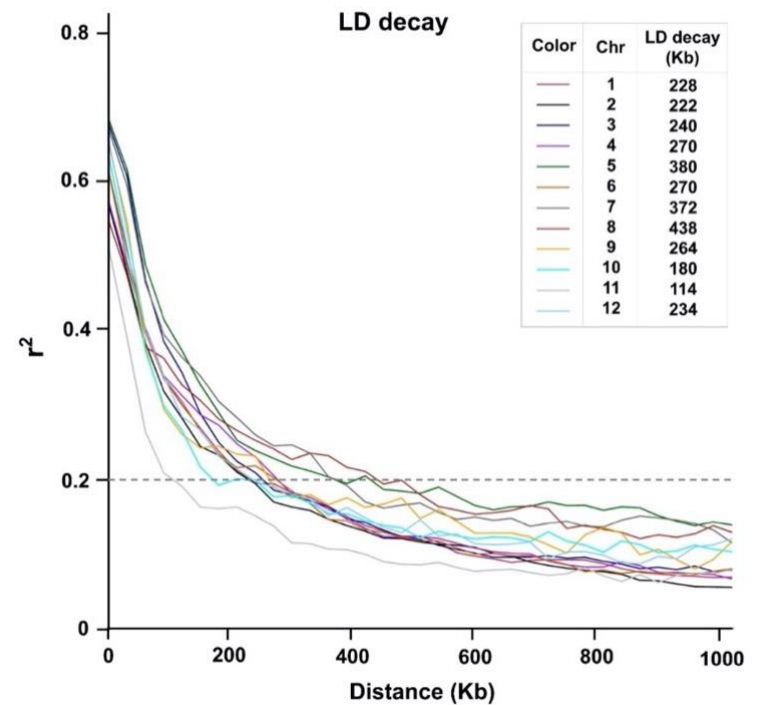
Figure 4. Overall chromosome-wide linkage disequilibrium (LD) decay estimated from the SNP genotypes of 236 rice associations. Each line plot represents a smoothed r 2 for all marker pairs on each chromosome depending on the distance between marker pairs. The cut-off threshold of LD decay (r 2 = 0.2) is indicated by a dotted line.